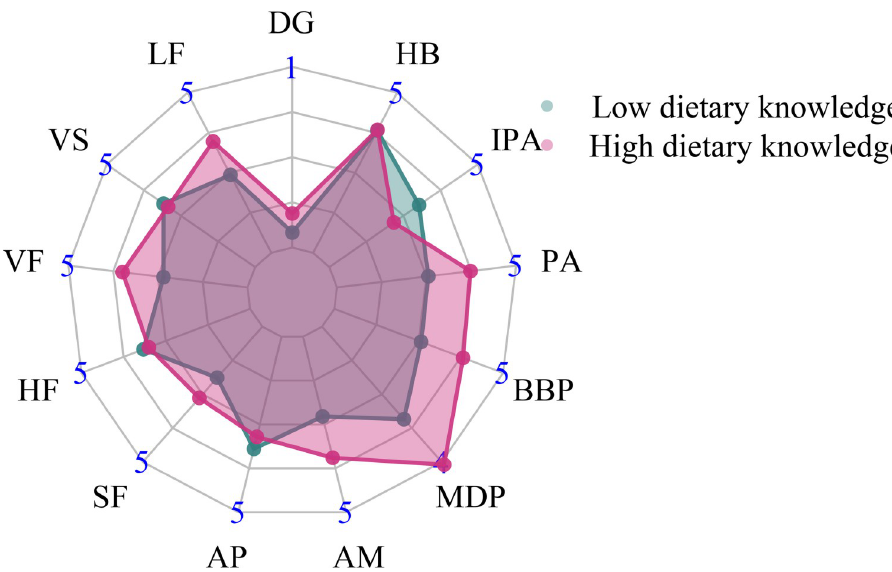
Fig 2. Radar plot for dietary knowledge of children and adolescents. DG: Do you know about the dietary guidelines for Chinese residents? LF: Choosing a diet with a lot of fresh fruits and vegetables is good for one’s health. VS: Eating a lot of sugar is not good for one’s health. VF: Eating a variety of foods is good for one’s health. HF: Choosing a diet high in fat is not good for one’s health. SF: Choosing a diet with a lot of staple foods (rice and rice products and wheat and wheat products) is not good for one’s health. AP: Consuming a lot of animal products daily (fish, poultry, eggs and lean meat) is not good for one’s health. AM: Reducing the amount of fatty meat and animal fat in the diet is good for one’s health. MDP: Consuming milk and dairy products is good for one’s health. BBP: Consuming beans and bean products is good for one’s health. PA: Physical activities are good for one’s health. IPA: Sweaty sports or other intense physical activities are not good for one’s health. HB: The heavier one’s body is, the healthier he or she is.